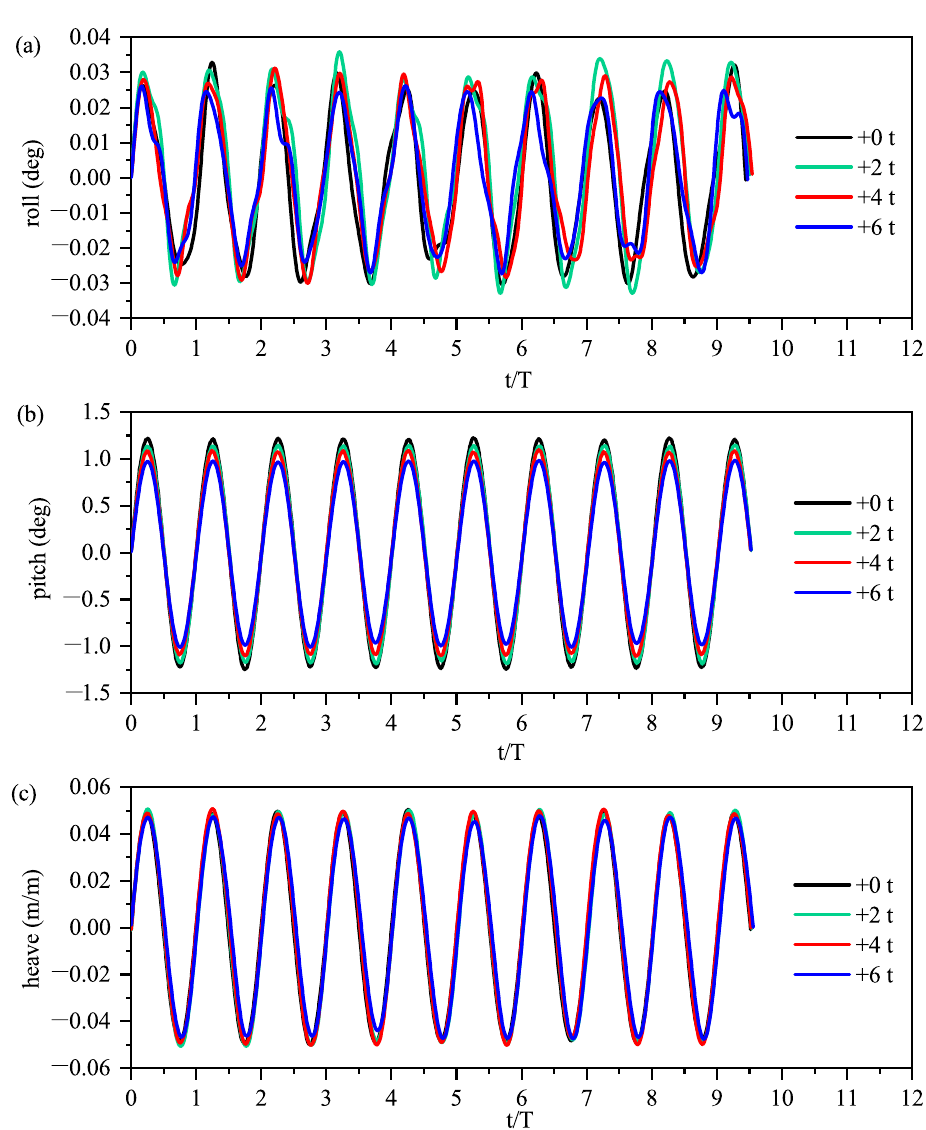
Figure 14. Motion response of the HFS in the roll, pitch, and heave direction by loading different mass blocks ( H = 1 m, T = 4.213 s): ( a ) roll response; ( b ) pitch response; ( c ) dimensionless heave